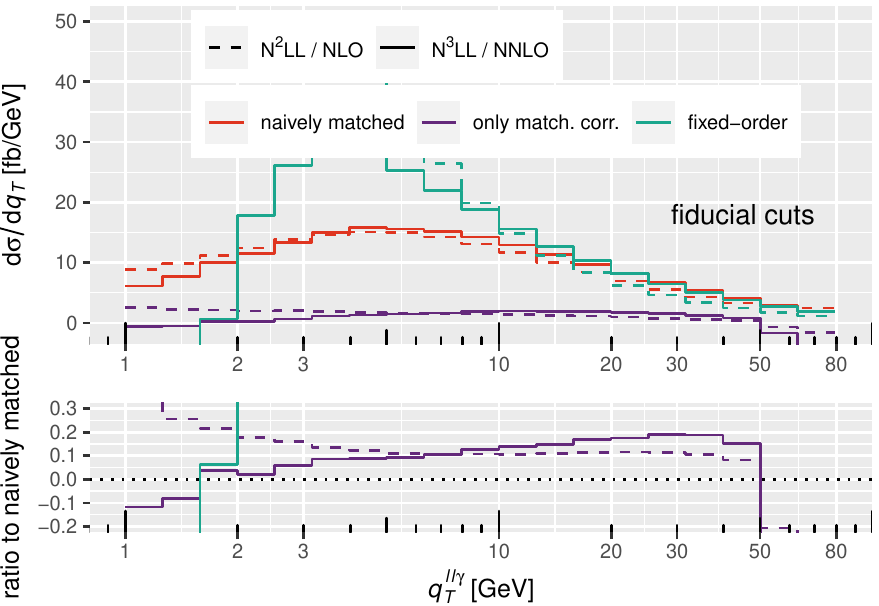
Figure 22. Z ( → e + e − ) γ transverse-momentum distribution with experimental fiducial cuts as in table 6. Shown are results with naive matching, the matching corrections by themselves, and the fixed-order predictions, each at order α s and α 2 , respectively. The bottom panel shows the ratio of s the matching corrections relative to the naively matched result for each order in α s